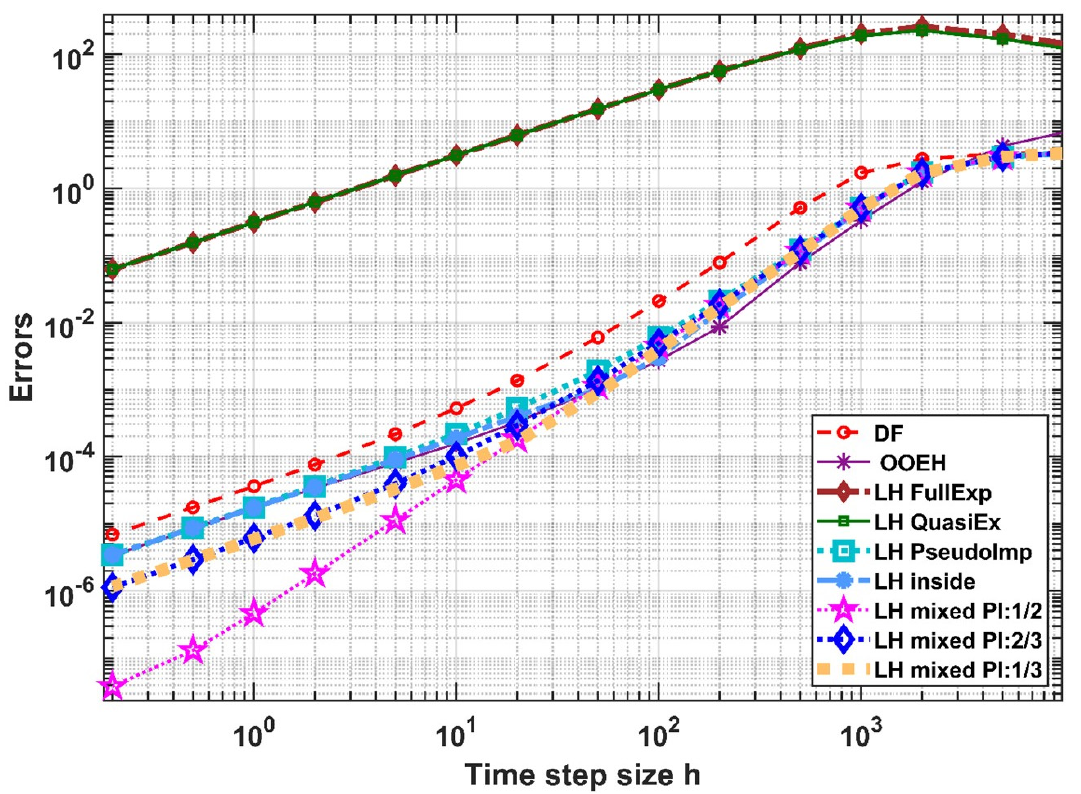
Figure 11. The maximum errors as a function of the time step size h for the nine versions of the method in the case of the surface area (Experiment 5). We emphasize that the labels referring to the treatments are now for the convection term.